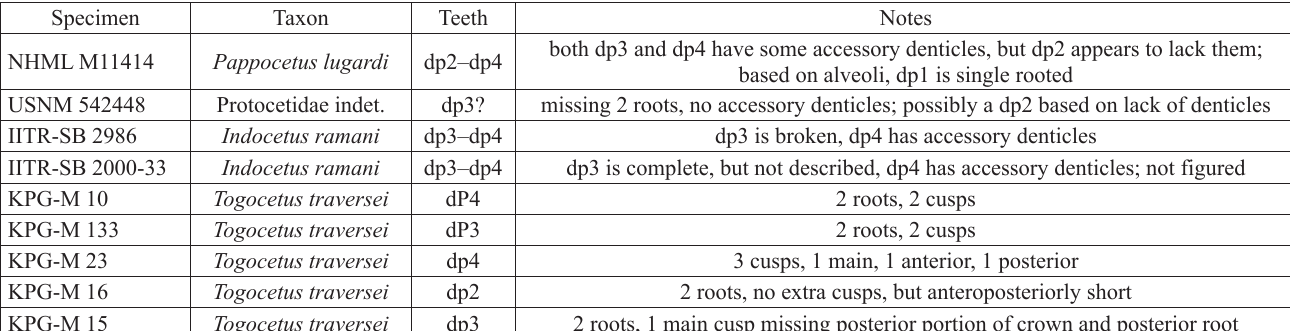
Table 1. All known protocetid specimens that include deciduous premolars, with descriptions of those specimens. Specimen Taxon Teeth